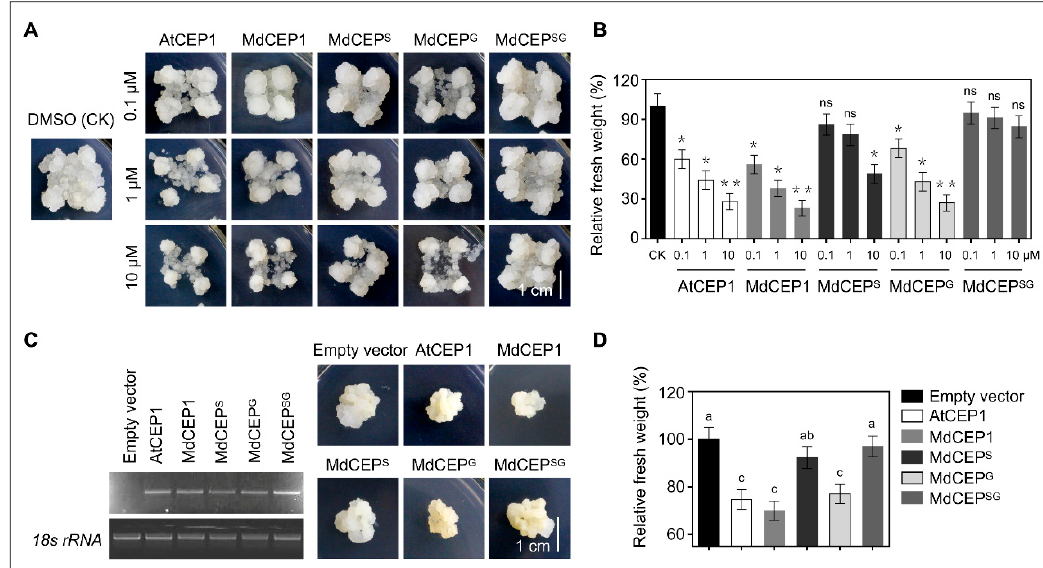
( B ) Conserved amino acids analysis of all MdCEPs and AtCEPs. Different substitution derivatives are obtained by changing the conserved amino acids indicate in red. (C) Inhibitory effects of exogenous AtCEP1 and MdCEP1 peptide on root growth of apple seedlings. Apple seeds were plated on MS medium with or without different CEP peptides and grown for 2 weeks. (D) Inhibitory effects of exogenous substitution derivatives of MdCEP1 on root growth of apple seedlings. Apple seeds were plated on MS medium with or without different CEP peptides and grown for 2 weeks. (E and F) The relative primary root length and lateral root number of various plants in (C and D). Error bars indicate SEM ( N = 3, n = 24). * p < 0.05; ns, no significance. (Student’s t -test).